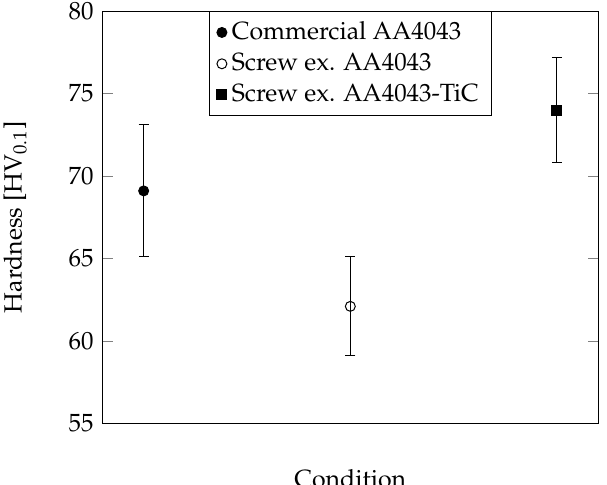
Figure 12. Micro-hardness of bead-on-plate deposited materials. AA4043-TiC is harder than the unreinforced parallels. The AA4043-TiC structure was negatively influenced by the presence of